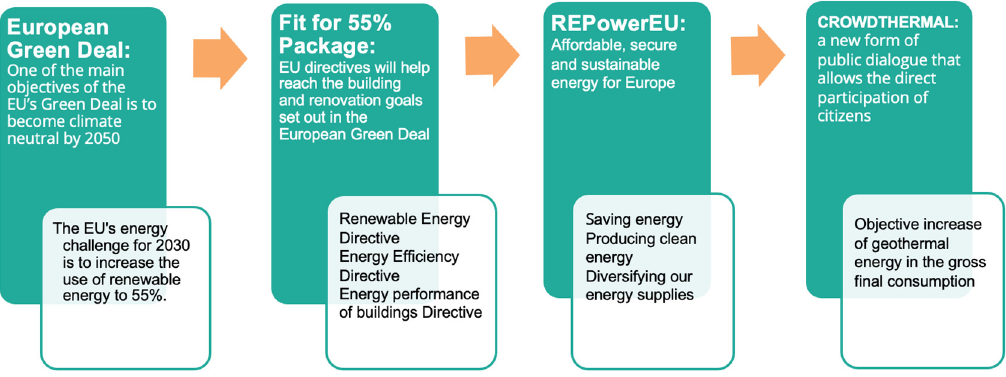
Figure 1. Political background for CROWDTHERMAL .